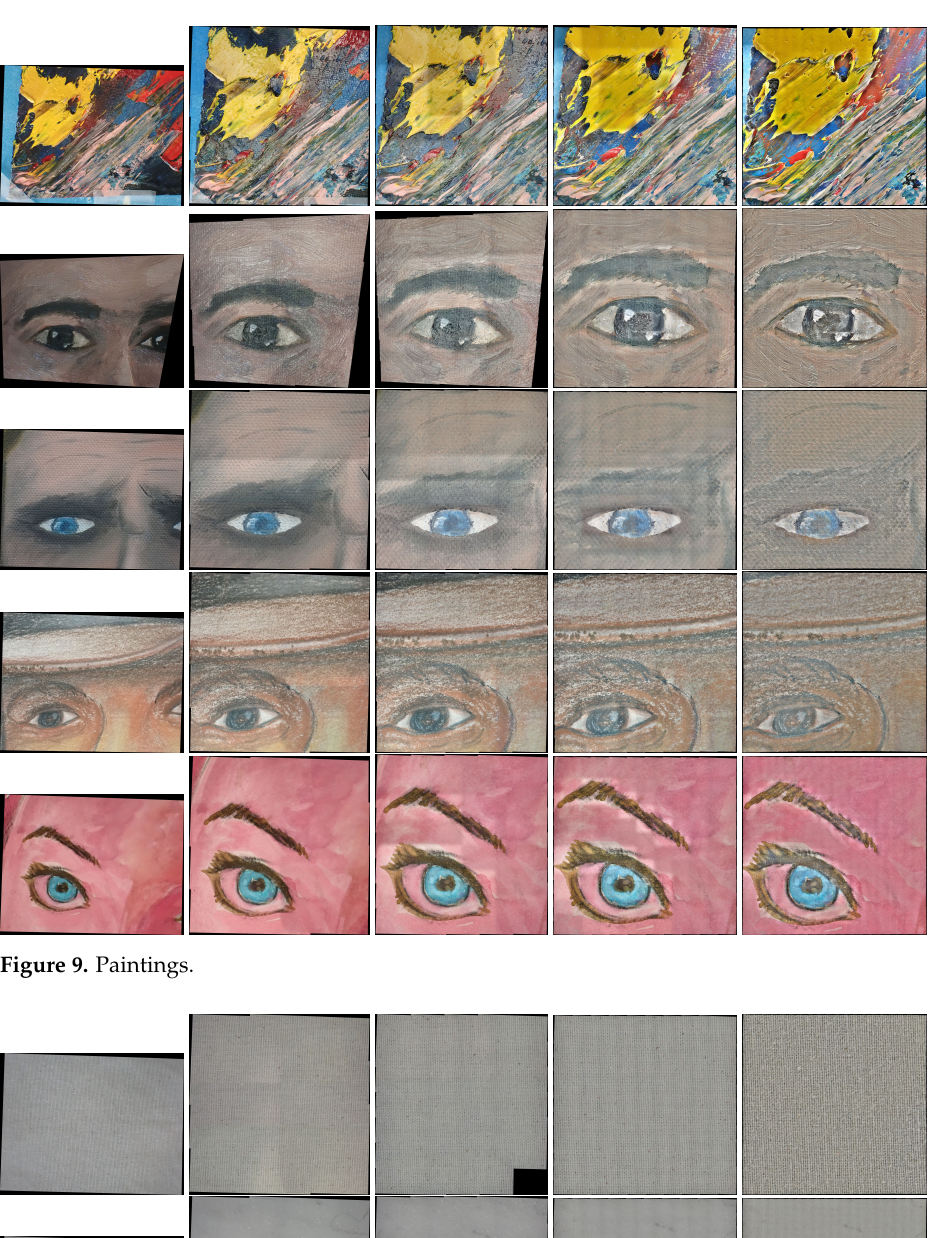
Figure 9. Paintings.